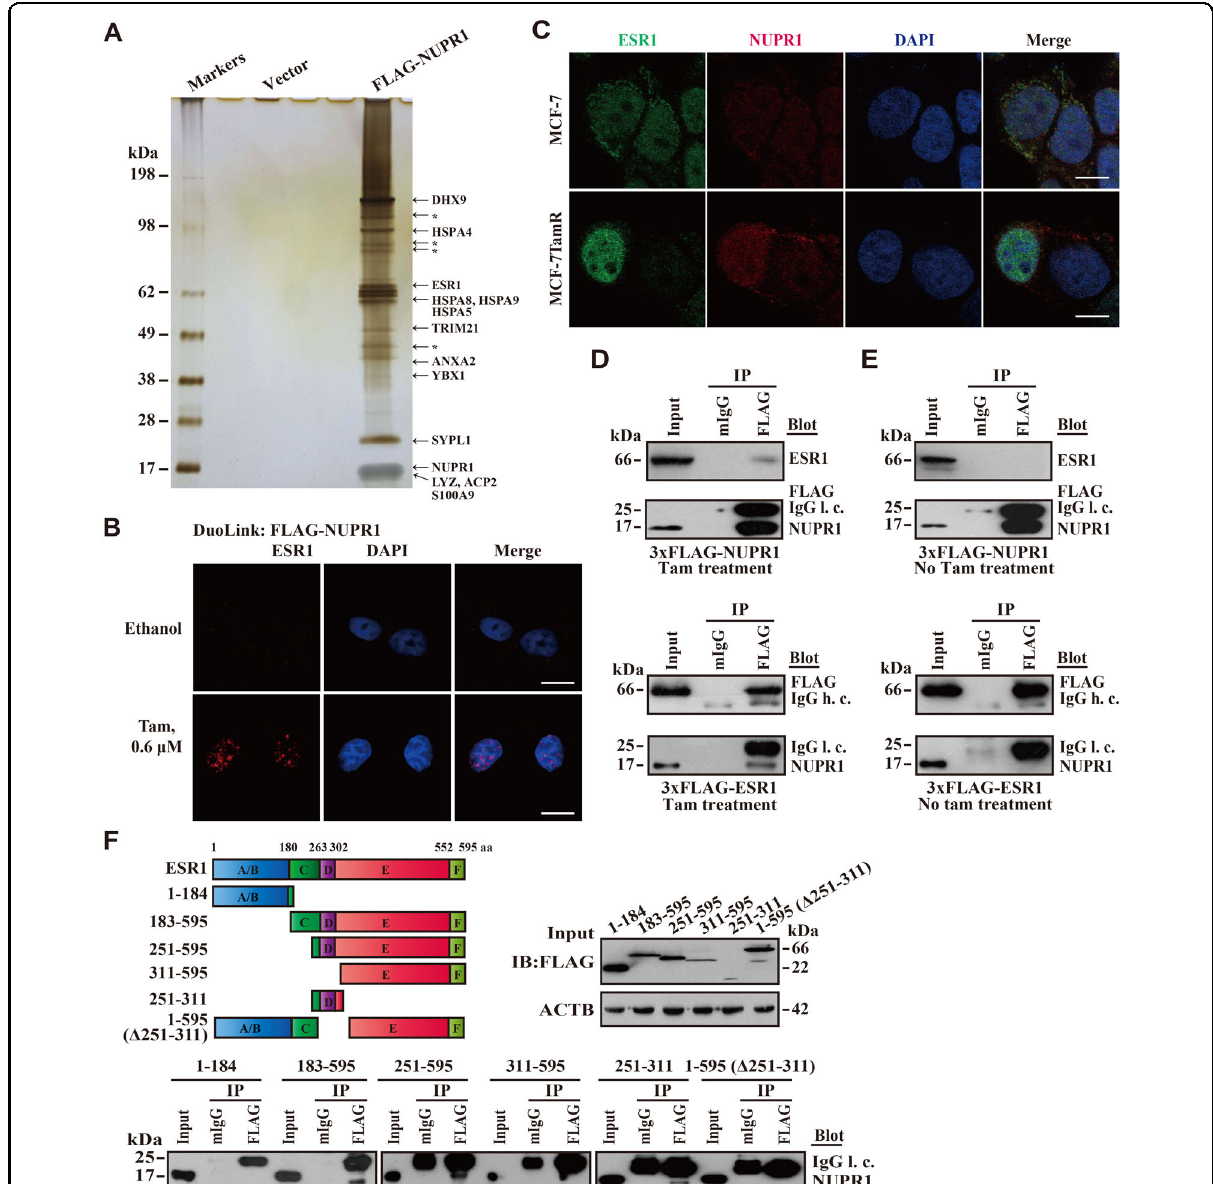
Fig. 4 NUPR1 physically interacts with ESR1. A Immuno-puri fi cation of NUPR1-containing protein complexes. Cellular extracts from MCF-7TamR cells stably expressing FLAG (empty vector, control) or FLAG-NUPR1 were immunopuri fi ed with an M2 anti-FLAG af fi nity gel and eluted with 3× FLAG peptide. The eluates were resolved by SDS-PAGE, and bands of interest were analyzed by mass spectrometry. *, nonspeci fi c binding proteins. B DuoLink assay of the interaction between FLAG-tagged NUPR1 and endogenous ESR1 (red) in MCF-7TamR cells treated with vehicle (ethanol) or 0.6 μ M Tam for 24h. Nuclei were counterstained with DAPI (blue). Scale bar, 10 μ m. C Representative immuno fl uorescence (IF) images of endogenous NUPR1 and ESR1 colocalization in MCF-7TamR but not in their parental cells. Green, ESR1; Red, NUPR1. Nuclei were counterstained with DAPI (blue). Scale bar, 10 μ m. D , E Flag-tagged NUPR1 or ESR1 was transfected into MCF-7TamR cells with or without Tam treatment for 48h. Immunoprecipitation (IP) of whole-cell lysates with an M2 anti-FLAG antibody and Western blotting analysis of the indicated proteins were conducted. IgG h. c. IgG heavy chain, IgG l.c. IgG light chain. F Co-IP assay of NUPR1 and ESR1. FLAG-tagged ESR1 or its serial deletions was transfected into MCF-7TamR cells and Western blotting analysis of the indicated proteins were conducted as in D , with ACTB as a loading control. Left: schematic representation of full-length ESR1 protein and its truncated forms. A/B, activating function; C, DNA-binding domain; D, nuclear localization signal; E and F, hormone-binding